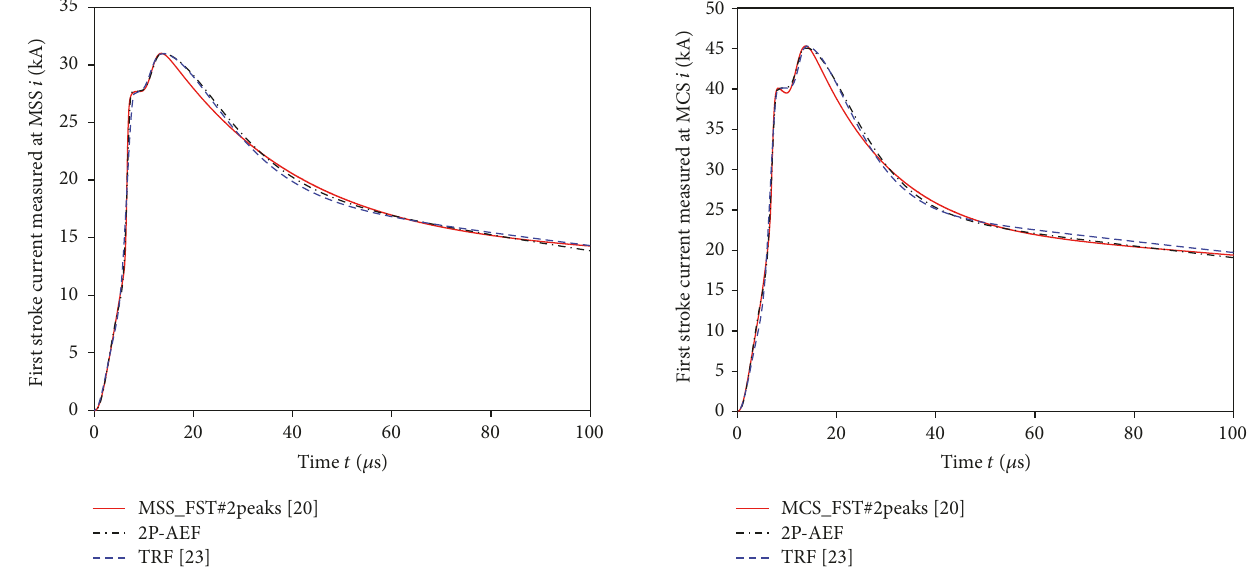
Figure 6: Measured current MSS FST#2peaks [20], TRF [23], and 2P-AEF(2,1,2).